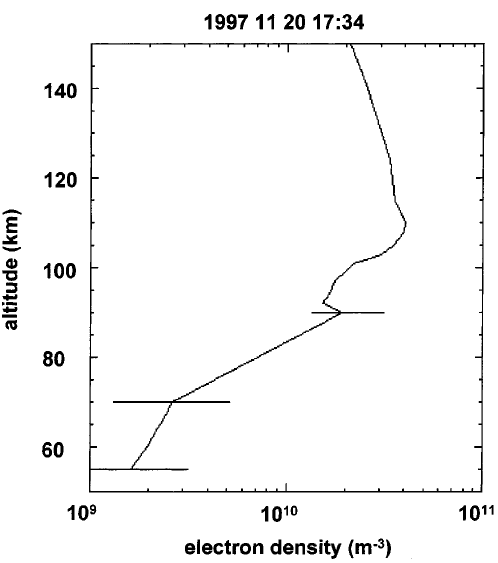
Fig. 9. Final composite plasma density profile for ISBJØRN I launch. See text